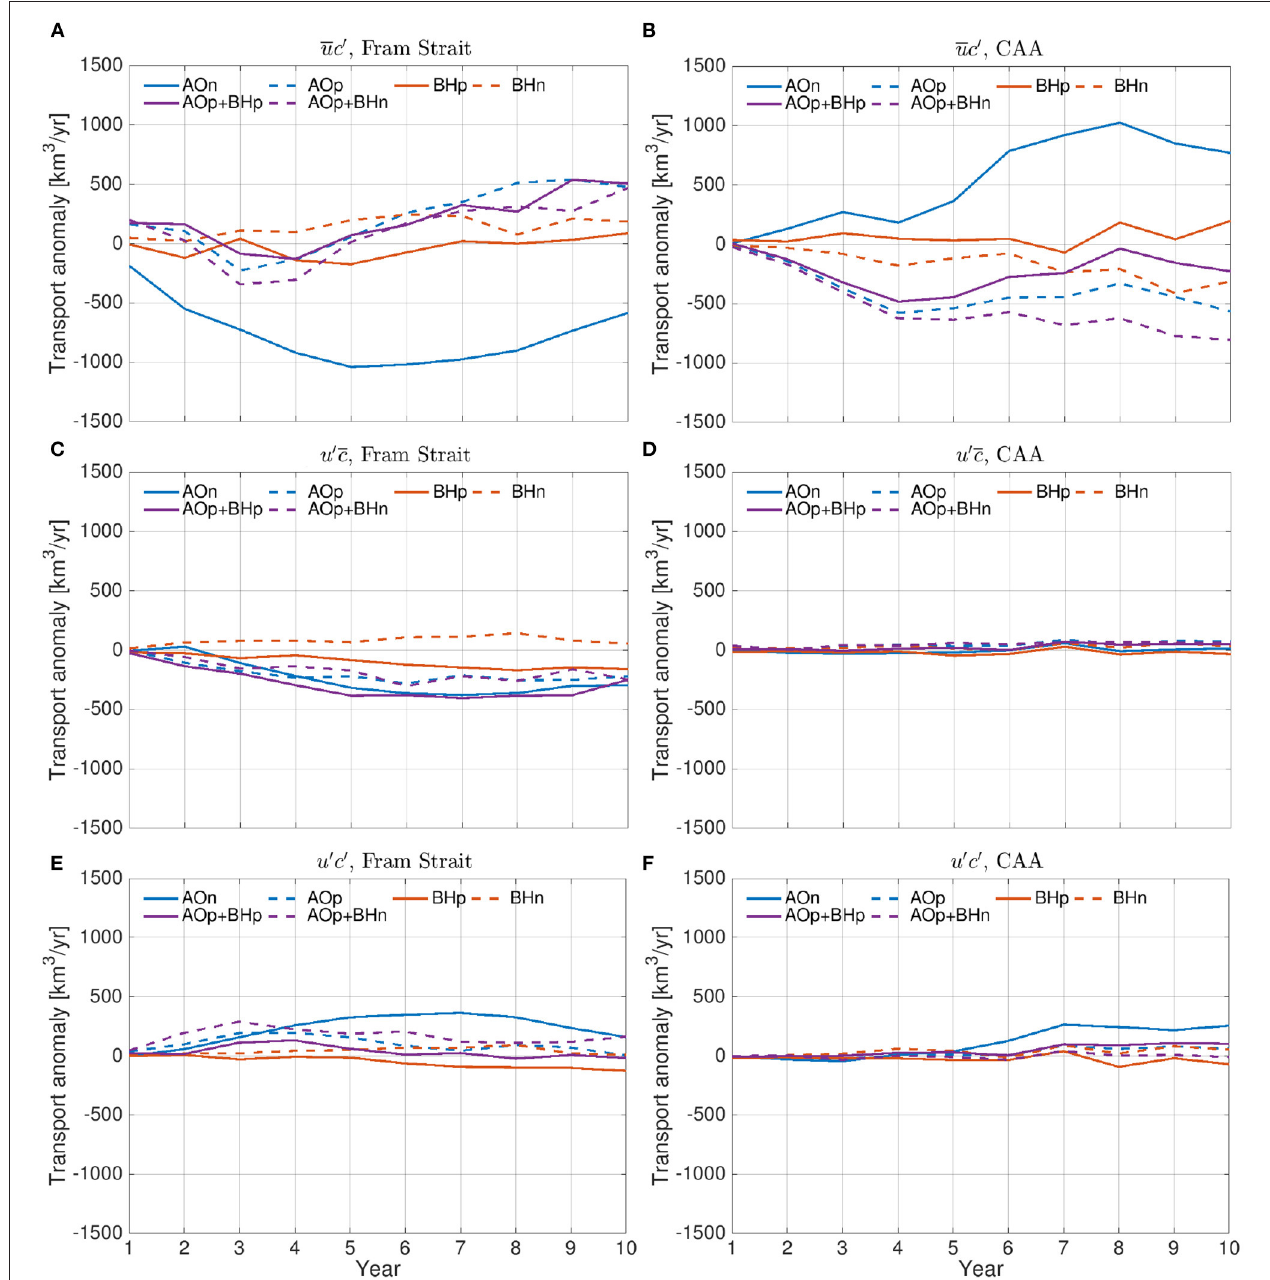
FIGURE 12 | Components of Eurasian runoff volume export anomaly through Fram Strait: (A) due to runoff concentration change, (C) due to ocean velocity change, and (E) due to their concurrent changes. (B,D,F) The same as (A,C,E) but for export through the Canadian Arctic Archipelago (CAA). The anomalies are relative to the control run. Positive values indicate larger